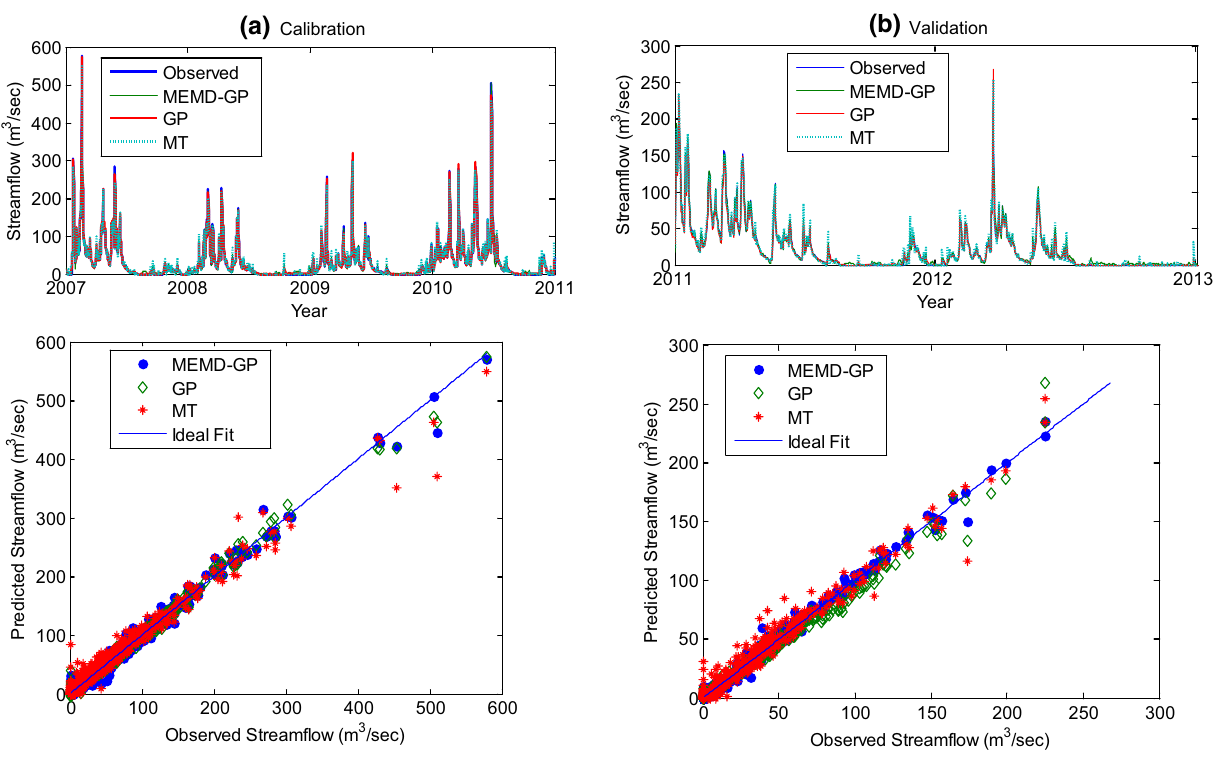
Fig. 7 Daily discharge predictions for Thumpamon station by different methods. Upper panels show time series plots; lower panels show scatter plots